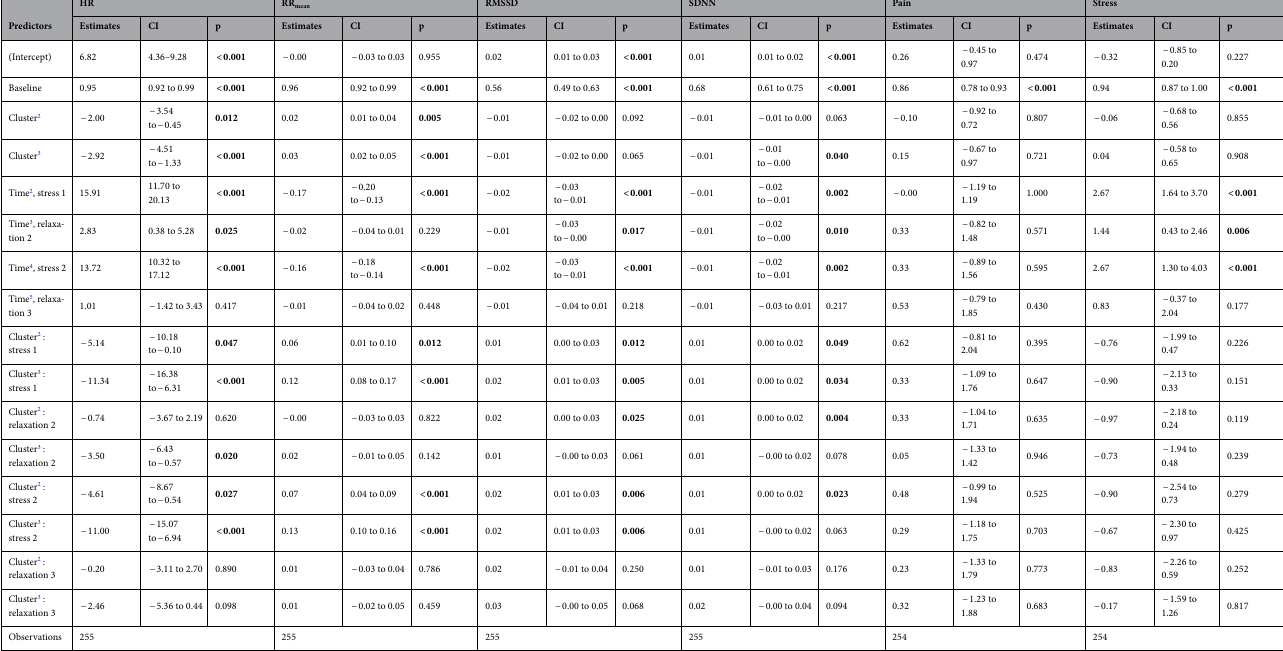
Table 4. Generalized linear models for heart rate (HR), mean interval between heart beats (RR mean ), root mean squared interval differences of successive beats (RMSSD), and the standard deviation of intervals between normal heart beats (SDNN), and subjective pain and stress, comparing the three fibromyalgia patient clusters. Significant values are in